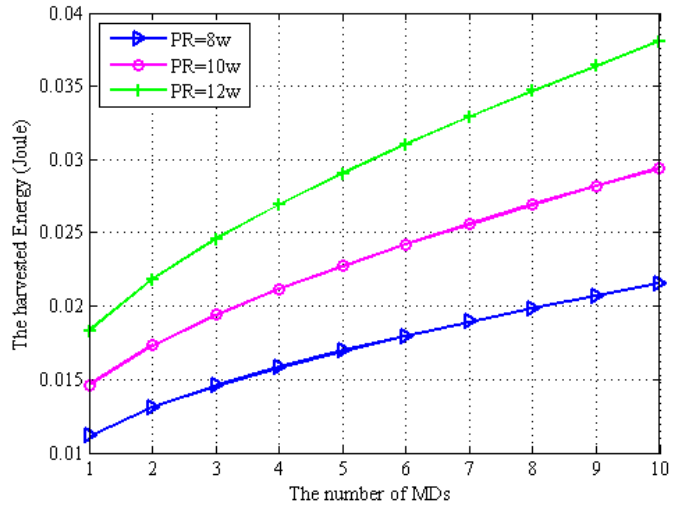
Figure 5. Energy consumption vs. the number of